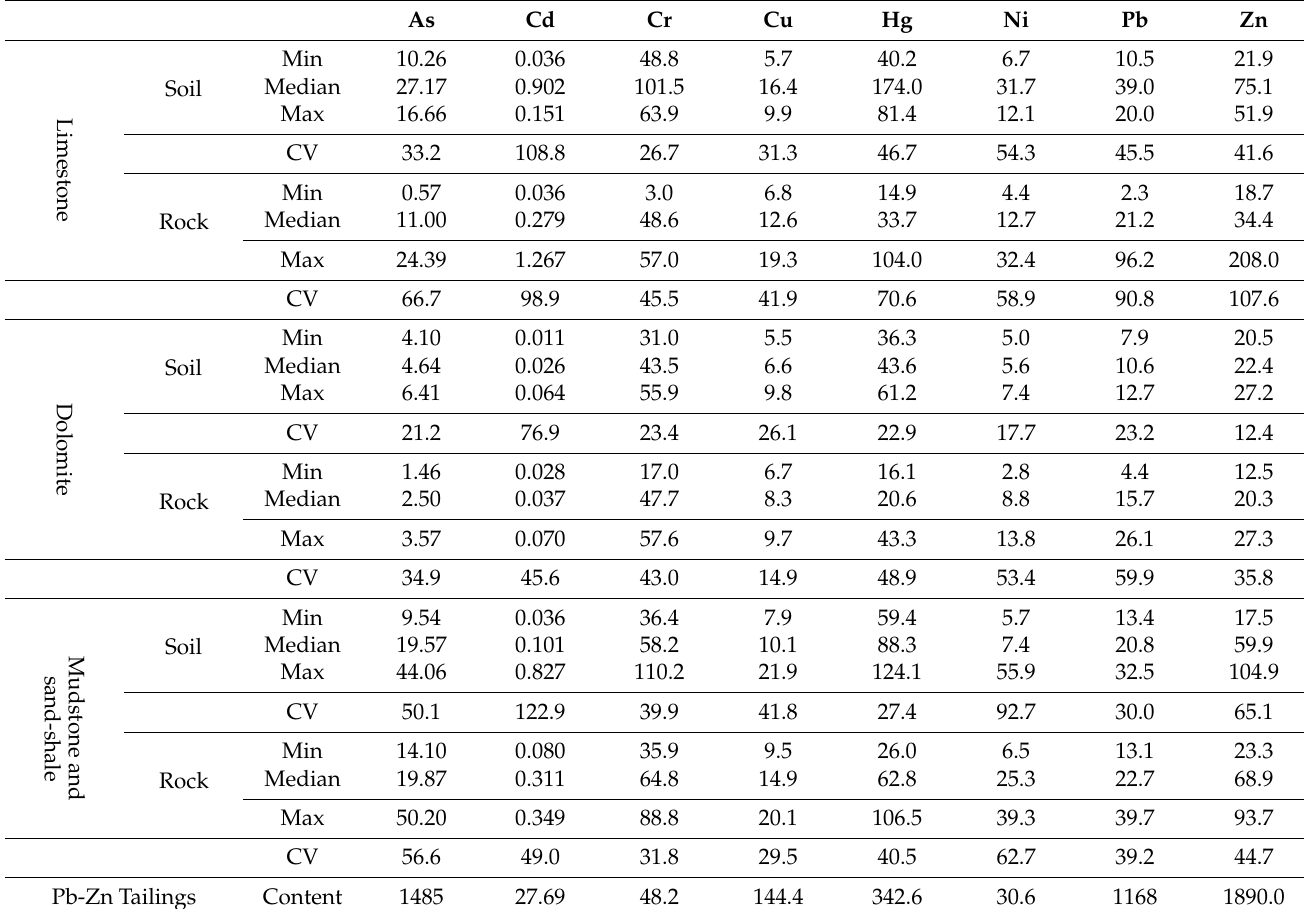
Table 2. Statistical parameters of toxic